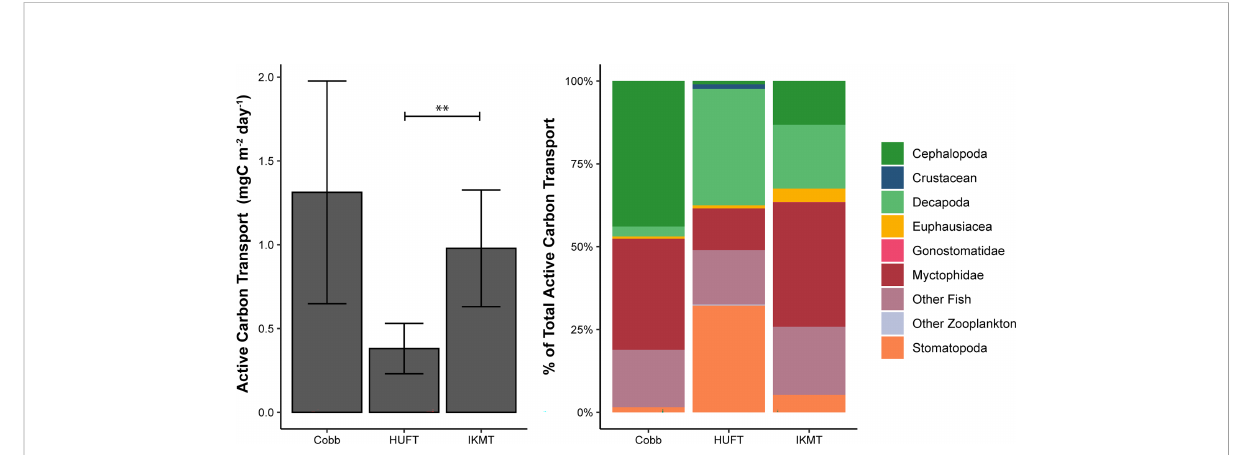
FIGURE 3 Left: Mean active carbon transport by the sampling gear (i.e., Cobb, HUFT, and IKMT). Bars indicate ± standard error of the mean. The horizontal bar indicates a statistically signi fi cant difference ( a = 0.05) between the HUFT and IKMT (where ** indicates p = 0.001); Right: Percent contribution of taxonomic groups to total active carbon transport by sampling gear (See Table 4 for total active carbon transport by gear and taxonomic group).